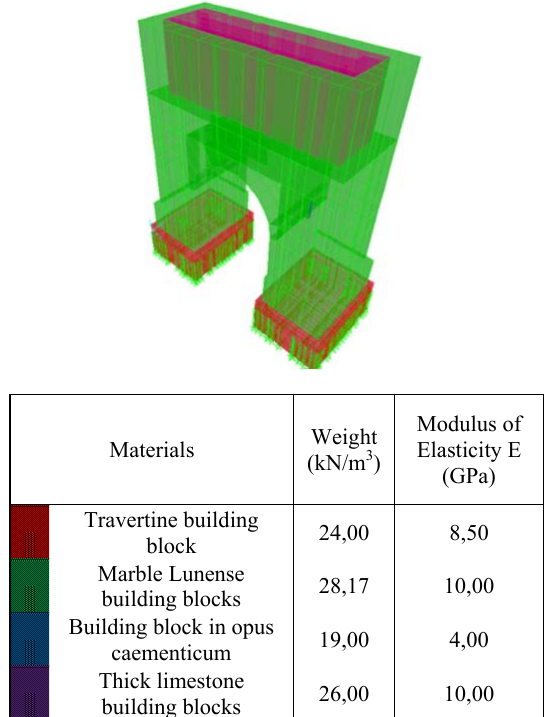
Table 2. Mechanical properties adopted for the reference FEM